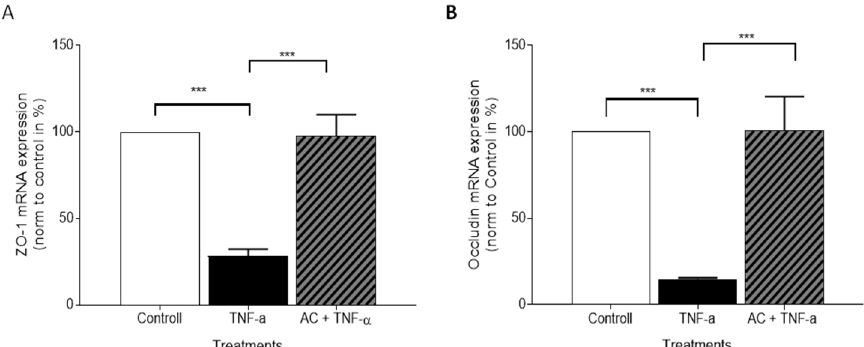
Figure 8. The effects of anthocyanin sour cherry extract on TNF- α induced ZO-1 and Occludin mRNA expression on HUVECs. Cell cultures were treated with TNF- α (10ng/mL) and 85 µ M AC + TNF- α (10ng/mL) for 24h. The mRNA level of ZO-1 ( A ) and Occludin ( B ) were determined by RT-qPCR and target genes were normalized to GAPDH and Control. Data are presented as mean ± SDs. n = 3. The significance of differences between sets of data was calculated by ANOVA. *** p < 0.001.